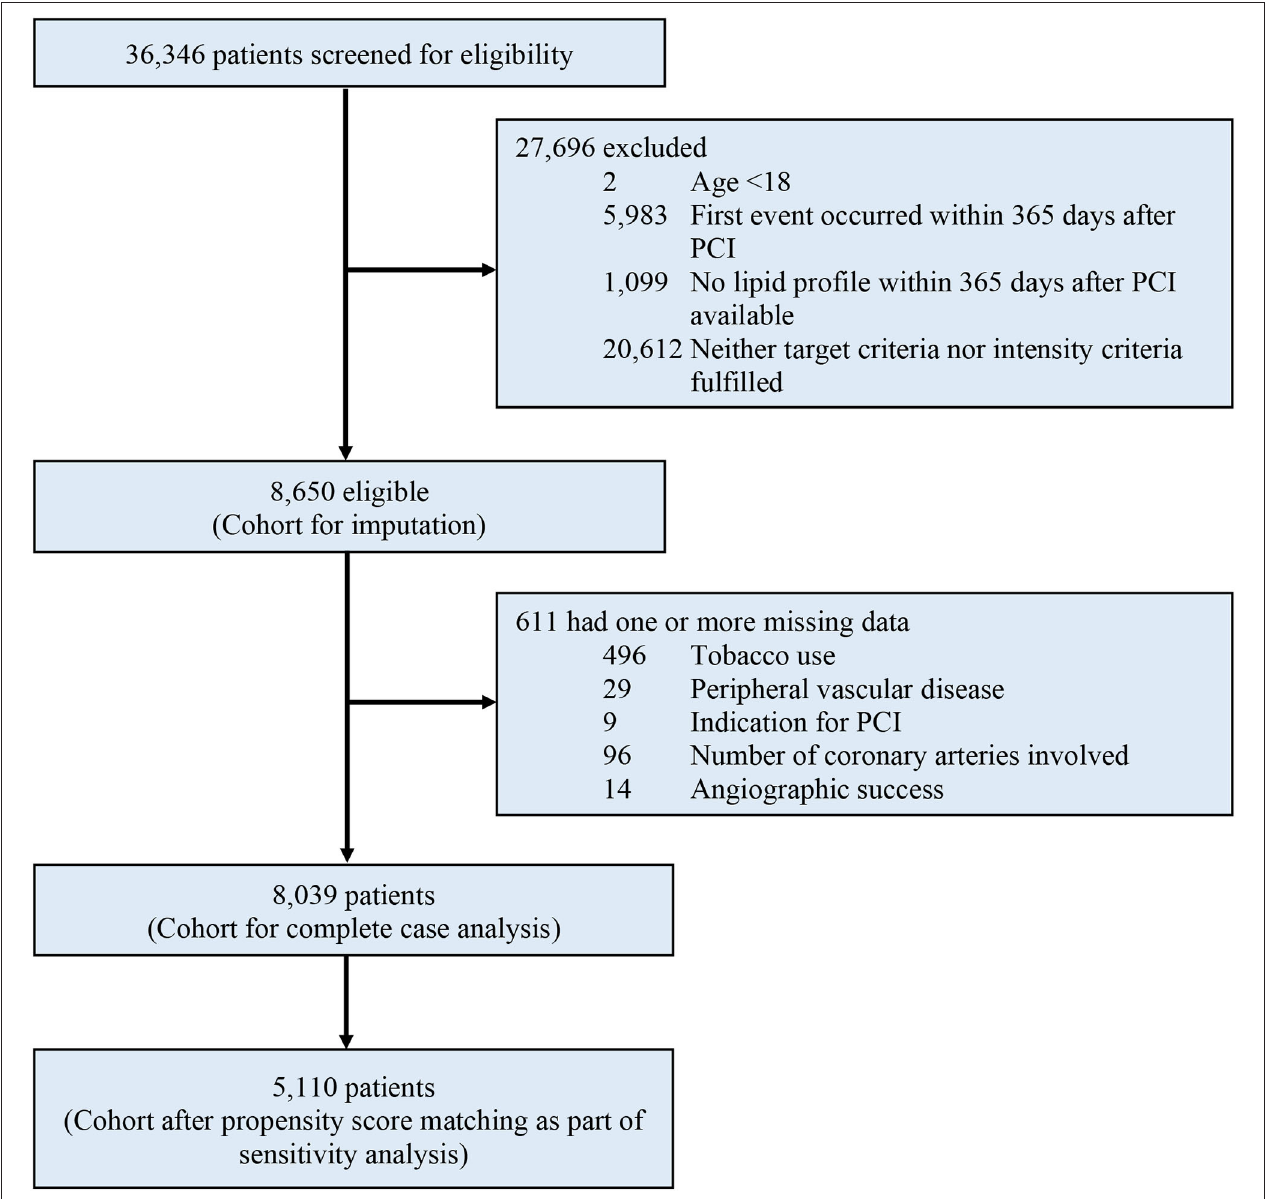
FIGURE 1 | Study profile. eGFR, estimated glomerular filtration rate; PCI, percutaneous coronary intervention.